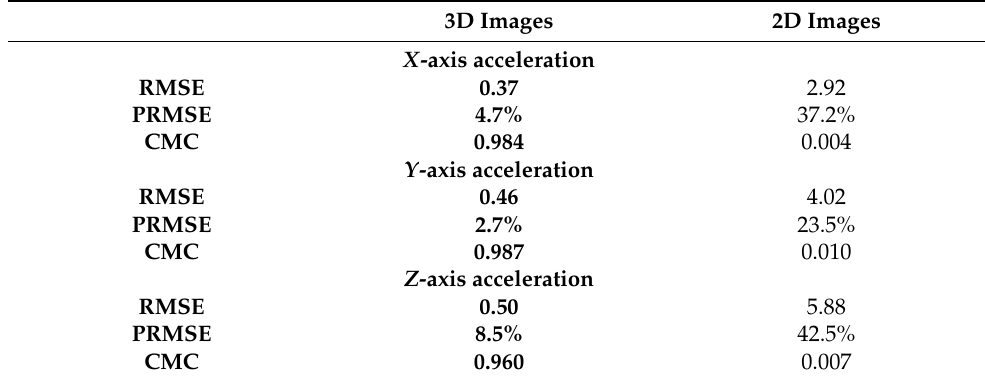
Table 4. Details for 2D/3D performance comparison in unknown-view testing. Note that the best performances are marked in